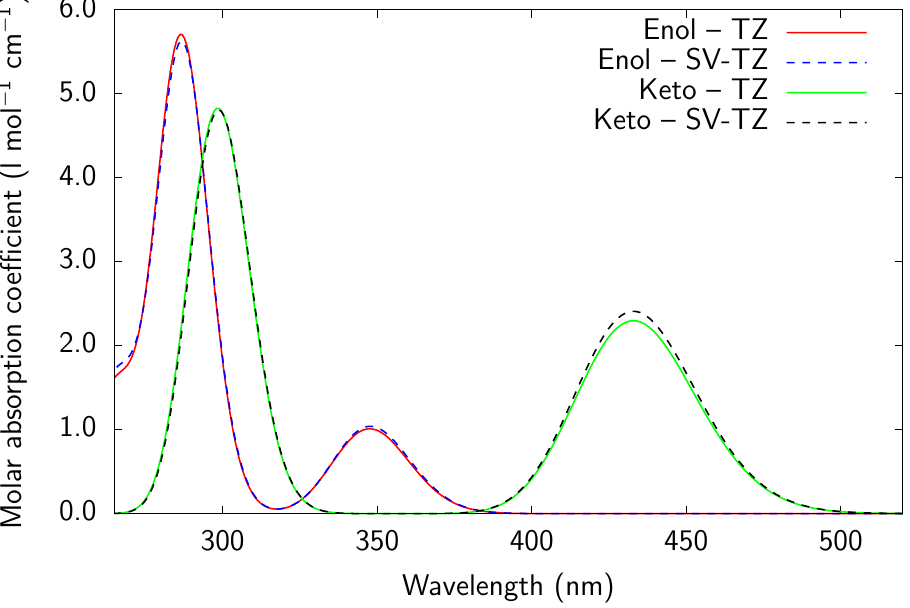
Figure 9. RI-CC2 composite (SV-TZ, dashed lines) and def2-TZVPD (TZ, full lines) spectra for the embedded heteromers of PYV3 · SA and PYV3 ·